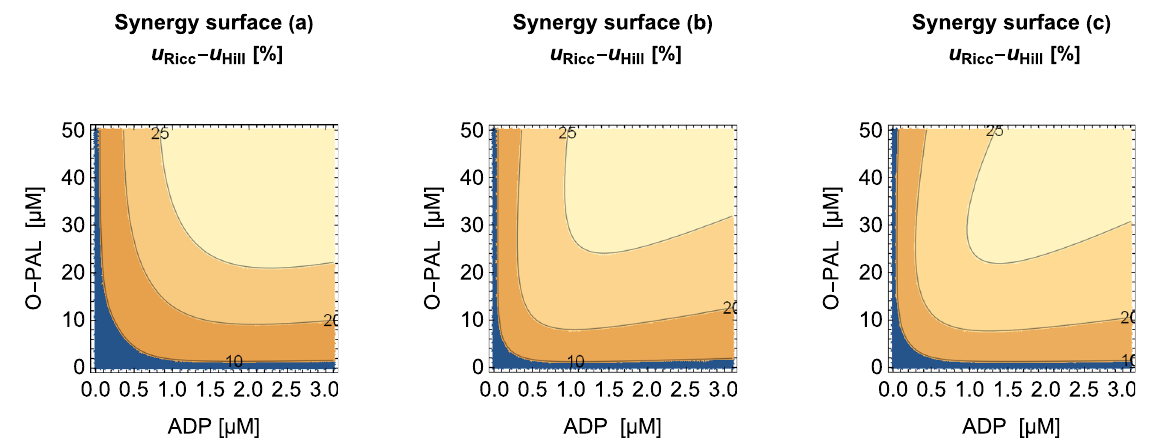
Table 1. Fit characteristics and parameters of anesthetics and their mixtures. a D 50 ( mg / kg ) , fraction of dose causing hypnosis in 50% of the population. b Slope of the dose-response curve. c Null-interaction model, Eq. (4). d Full interaction model, Eq. (35). e Between maximum effects δ ab , slopes δαβ and inflection points δ m δαβγ , δ m abc for ternary mixture) f Calculated effect-difference between full- and null-interaction models, [%]. g Goodness of fit according to the Akaike Information Criterion. h RMSE = root-mean-square error with respect to exptl. data. i p-values from the Wilcoxon-Mann-Whitney test. j,k,l Propofol, Midazolam, Alfentanil.